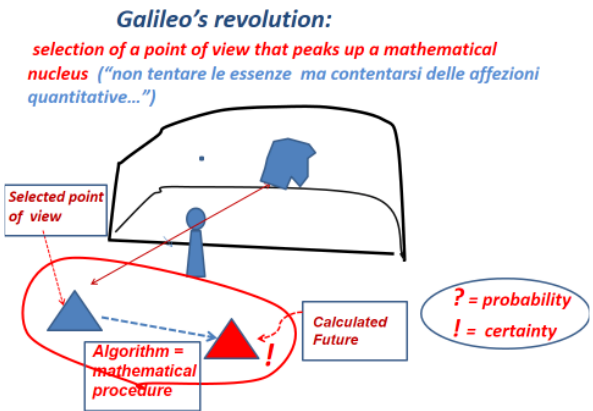
Figure 4. Once the object under investigation is reduced to a col- lection of mathematical features, one applies millennia of math- ematical wisdom and predicts the future